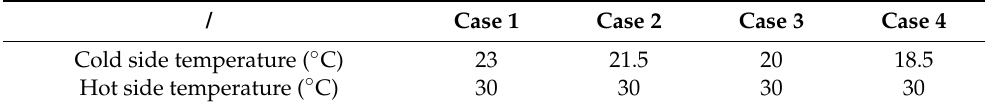
Table 3. Four cases of temperature span.